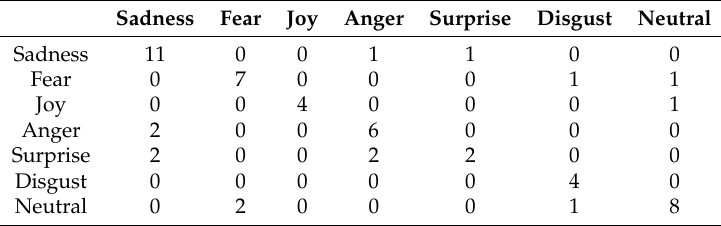
Table A26. A9 actor confusion matrix from the Emo-DB in the third phase.